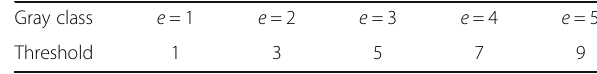
Table 4 Threshold corresponding to each gray class Gray